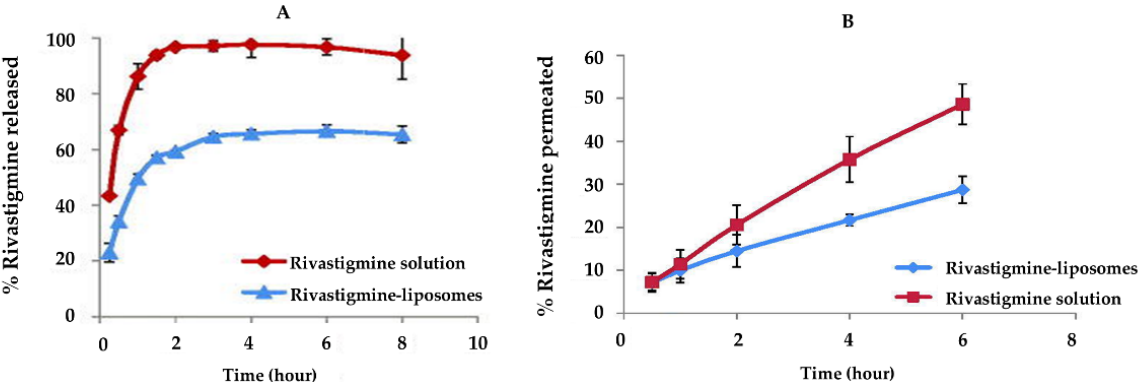
Figure 3. ( A ) in vitro release profile and ( B ) in vitro permeation profile of rivastigmine. Blue and red markers correspond to rivastigmine-loaded liposomes and rivastigmine solution, respectively. Adapted with permission from [72], copyright © 2017, published by Informa UK Limited.